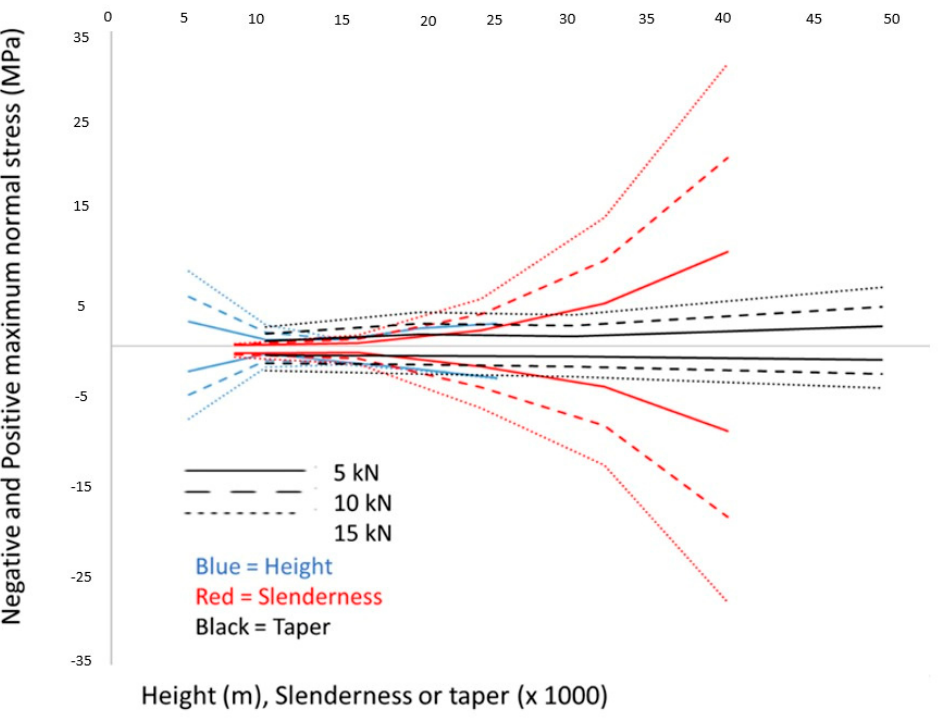
Figure 6. Behavior variation of the maximum positive and negative normal stresses versus tree height (m), slenderness, and taper ( × 1000) for the three levels of simulated horizontal forces (5 kN, 10 kN, and 15 kN). Table 7. Regression models considering maximum (negative and positive) normal stresses ( σ ) as a function of height ( H ), slenderness ( λ ), and taper ( T × 10 2 ) for each level of horizontal load adopted.